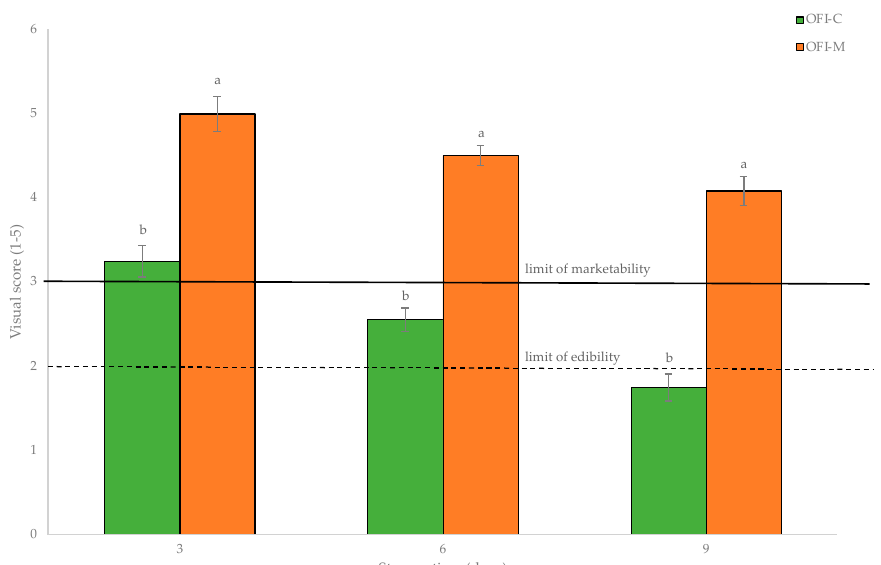
Figure 6. Visual score of minimally processed O. ficus-indica non-treated fruit (OFI C) and treated fruits with mucilage (OFI M) during cold storage (9 days at 5 ◦ C). Different lowercase letters indicate significant differences (Tukey’s test at p ≤ 0.05) between the treatments in each sampling date. Data are the mean ± SE (Vertical bars represent standard error; n = 5). [(5 = very good, 4 = good, 3 = fair (limit of marketability), 2 = poor (limit of edibility) and 1 = very poor (inedible)].